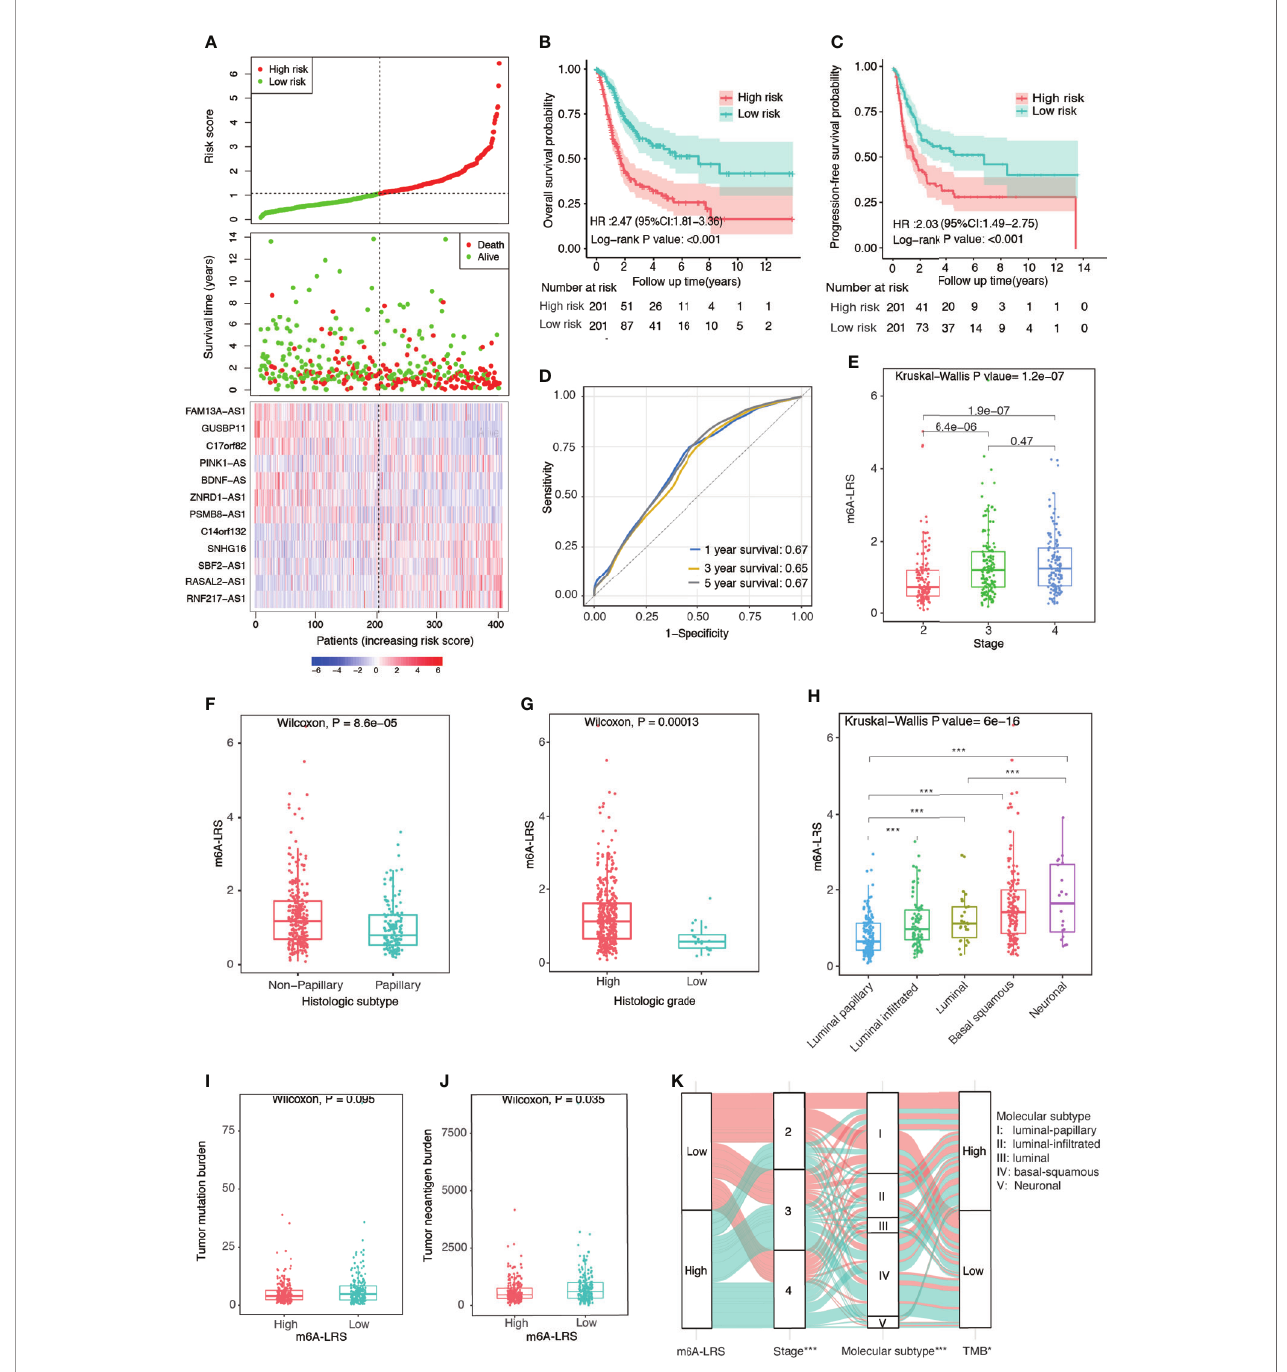
FIGURE 2 | Clinical relevance of the m6A-related lncRNA risk score in the TCGA dataset. (A) Distributions of the m6A-related lncRNA risk score (m6A-LRS), survival status, and the expression levels of 12 prognostic m6A-related lncRNAs in patients with bladder cancer in the TCGA cohort. (B, C) Kaplan – Meier curves reveal worse overall survival and progression-free survival in the high-risk than the low-risk subgroup. (D) Receiver operating characteristic (ROC) curves of m6A-LRS for predicting the 1/3/5-year survival in the TCGA dataset. (E – H) Comparison of m6A-LRS-based subgroups with regard to clinical stage (E) , histological subtype (F) , histological grade (G) , and molecular subtype (H) . (I, J) Comparison of tumor mutation burden (TMB) and tumor neoantigen burden (TNB) between the high- and low-risk subgroups. (K) Alluvial diagram showing the changes in m6A-LRS, clinical stage, molecular subtypes, and TMB. TMB was strati fi ed into high- and low-TMB group according to the median value. *P < 0.05, ***P < 0.001 for chi-square test between m6A-LRS subgroup and the corresponding